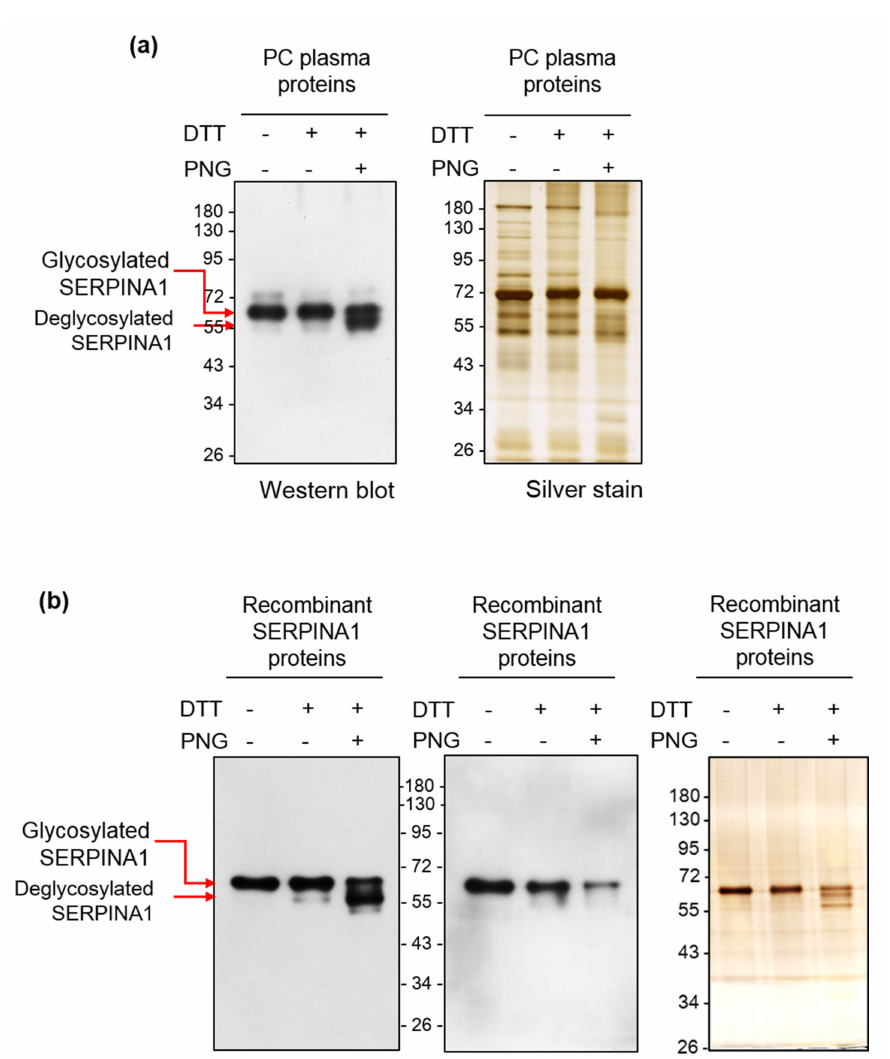
Figure 4. Deglycosylation of SERPINA1 protein by PNGase F alters its apparent molecular weight and AAL lectin-binding activity. ( a , b ) PC plasma proteins (2 µ g) and recombinant SERPINA1 protein (200 ng) were treated with or without PNGase F (PNG) (protein/PNGase F = 10 µ g/1U and 1 µ g/1U, respectively) at 37 ◦ C for 20 h and subjected to Western blot (for SERPINA1) or AAL blot analysis. Protein pattern revealed by silver staining is shown as loading